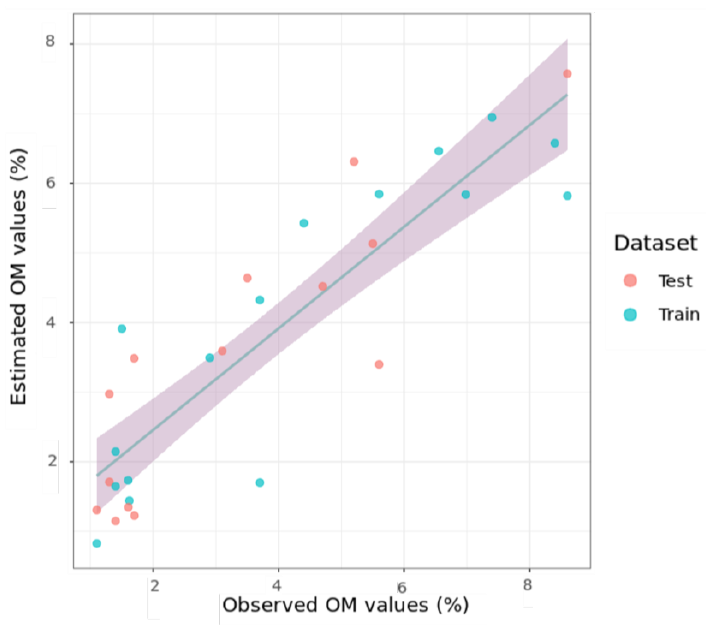
Figure 11. Scatter plot of the best fitted model (Cubist, absorbance, Savitzky–Golay 1st derivative, and SNV normalization) for OM prediction using PRISMA data, including the regression line (blue) with the 95% confidence interval (grey).